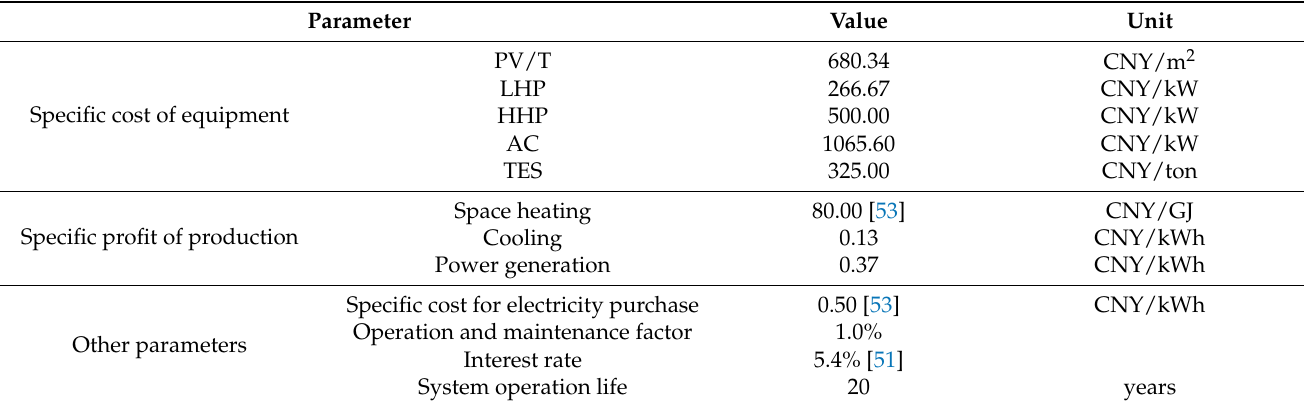
Table 4. System economic